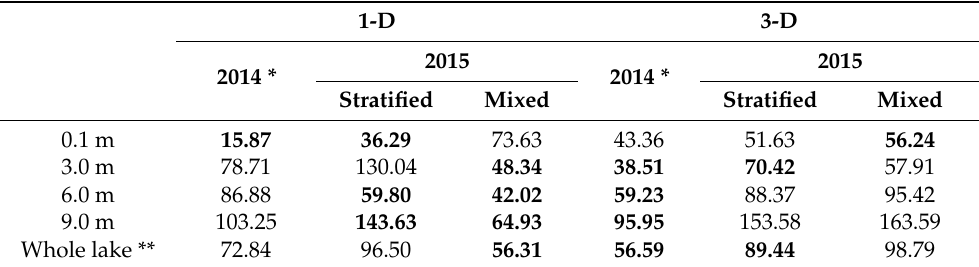
Table 4. The RMSEs of the predicted DO (in mmol/m 3 ) at different depths for 2014 and 2015. Lower RMSEs between the 1-D and 3-D model results are shown in